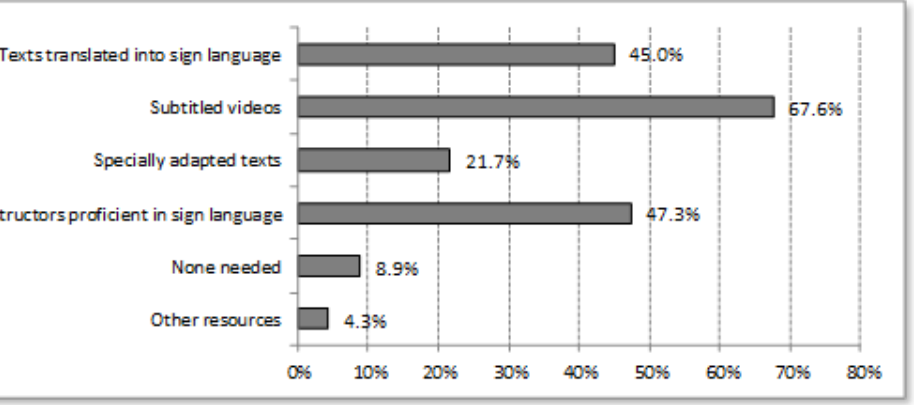
Figure 17. List of accessibility requirements specified by the deaf and hard of hearing for online courses (relative data). Multiple answers possible. Base: 484.